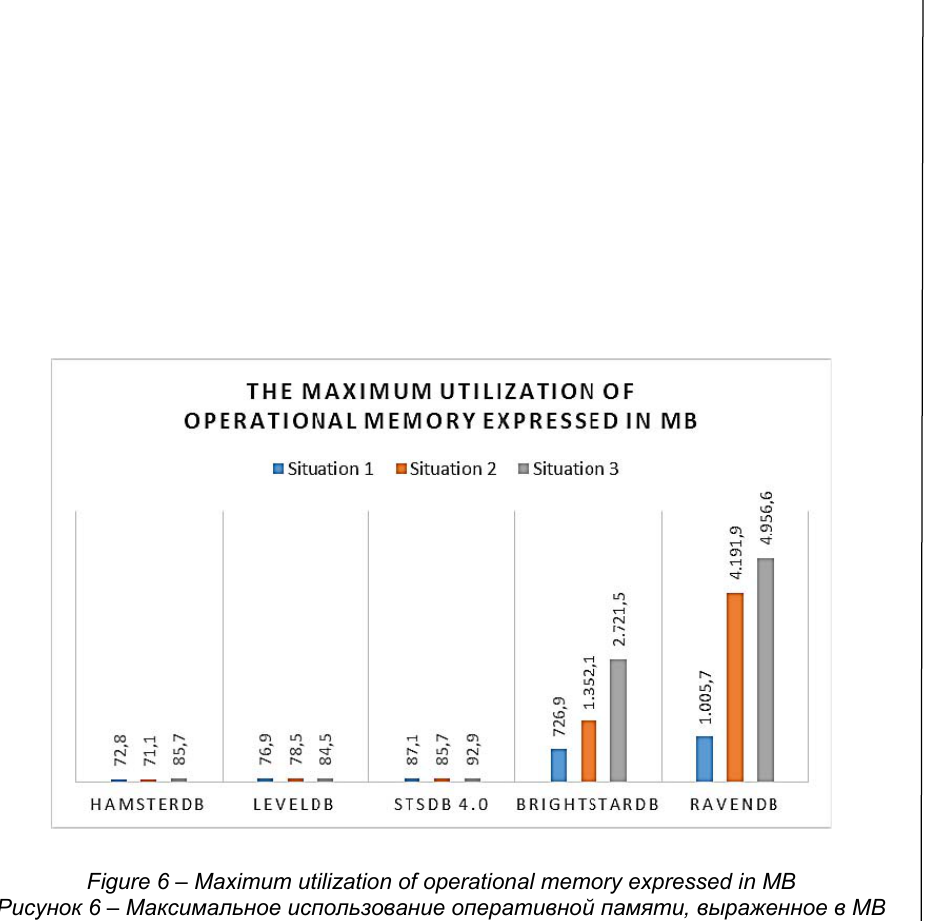
Figure 6 – Maximum utilization of operational memory expressed in MB Рисунок 6 – Максимальное использование оперативной памяти , выраженное в MB Слика 6 – Максимум искоришћења оперативне меморије изражен у